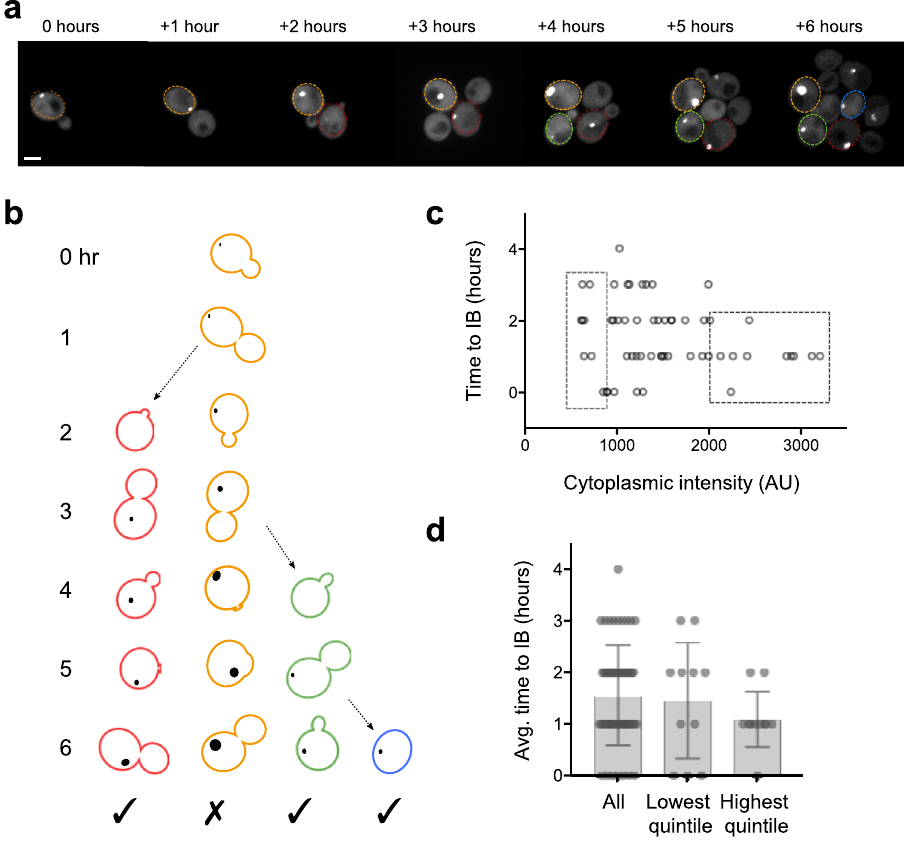
Fig. 2 Time to the formation of inclusion bodies is not strongly correlated with cytoplasmic intensity. a A typical fi eld of cells imaged over a 6-h timecourse is shown; the maximum projection includes sections containing inclusion bodies. Outlines indicate the cells shown in b . The contrast has been set to identical parameters for all images. Scale bar, 2 μ m. b Diagram illustrating criteria for inclusion in this analysis, showing the original cell in a and three cells born during the experiment. For the analysis in c and d , measurements were taken only from cells that were born during the experiment and formed a new inclusion body (checkmark). c Scatter plot of cytoplasmic GFP intensity vs time elapsed between the birth of a cell and formation of an inclusion body (IB). There is a slight non-signi fi cant correlation between early birth and high intensity ( n = 56, Pearson ’ s r = − 0.22, p = 0.11). Boxes indicate cytoplasmic intensities in the lowest and highest quintiles. d Time to IB formation for cells in the lowest and highest quintiles of cytoplasmic intensity, and for all cells analyzed (mean ± SD, n = 56, 11, 11). The difference between times to IB formation is not signi fi cant (Kruskal – Wallis test across all three categories, p = 0.32; Mann – Whitney test between all IBs and the highest quintile, two-tailed distribution, p =